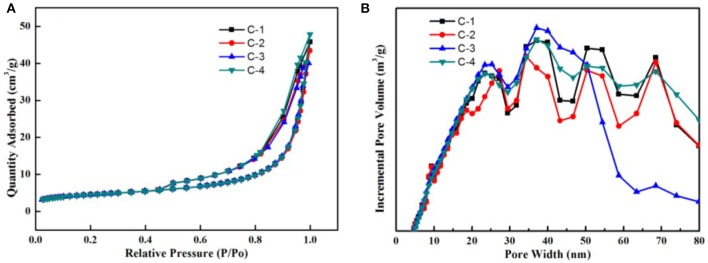
(A) N2 adsorption-desorption isotherms at 77 K; (B) pore size distributions.